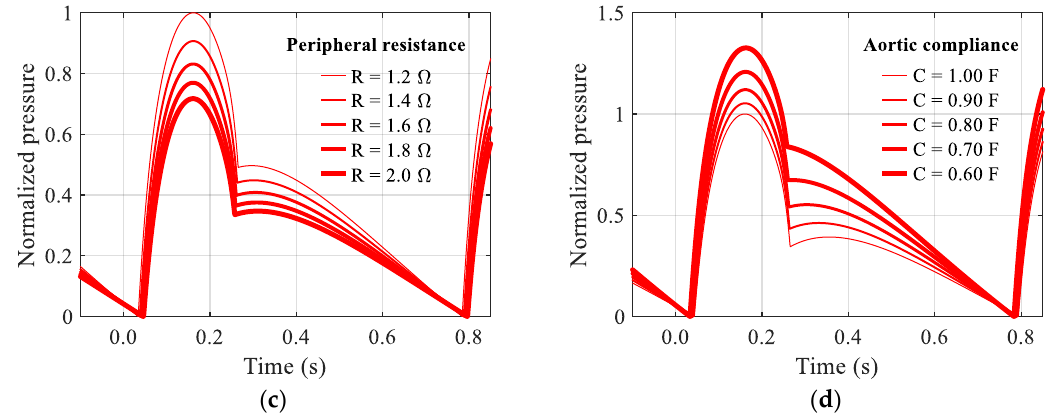
Figure 3. Simulation of the 4-element windkessel model: ( a ) implemented electric circuit of the 4-element windkessel model; ( b ) simulated pressure waveforms at the ventricle and aorta; ( c ) normalized aortic pressure according to various peripheral resistance; ( d ) normalized aortic pressure according to various aortic compliance.